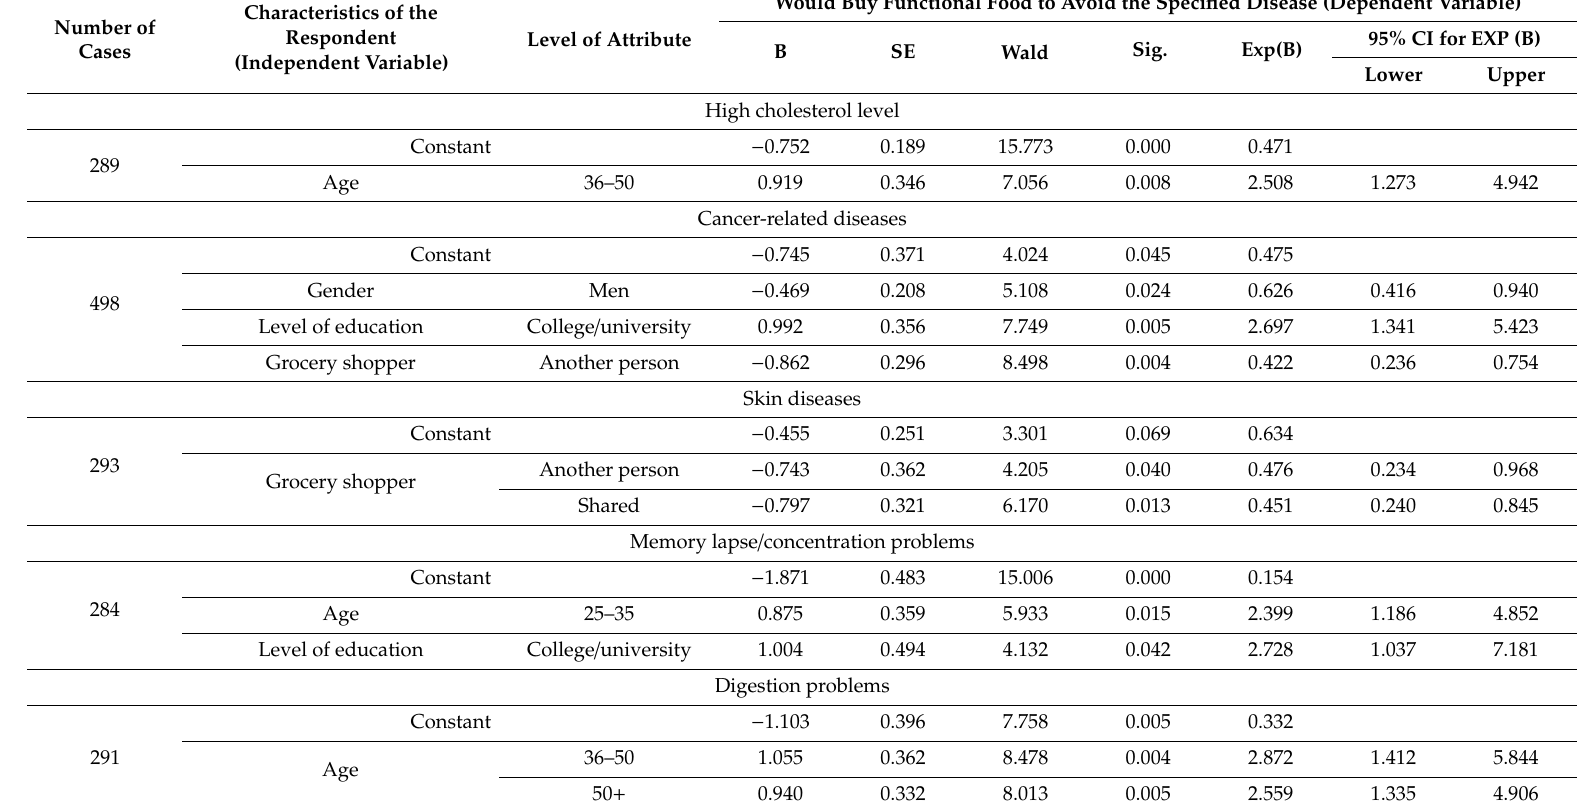
Table 4. Results of the binary logistic